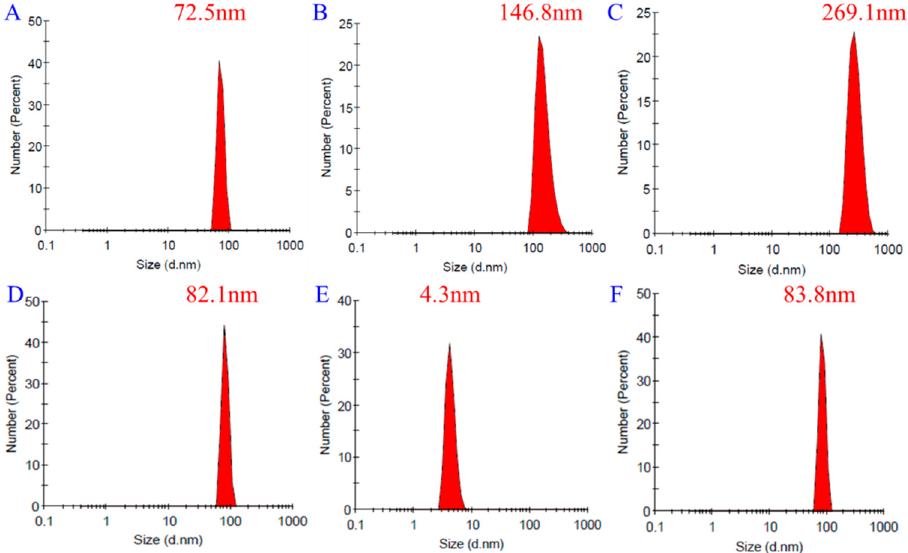
Figure 5. DLS results for FA-2-DG at concentrations of ( A ) 8 × 10 − 6 mol L − 1 in pure water, ( B ) 14 × 10 − 6 mol L − 1 in pure water, ( C ) 47 × 10 − 6 mol L − 1 in pure water, ( D ) 9.5 × 10 − 6 mol L − 1 in pure water, ( E ) 0.5% bovine serum albumin (BSA) aqueous solution without FA-2-DG, and ( F ) 9.5 × 10 − 6 mol L − 1 in aqueous 0.5% BSA solution.